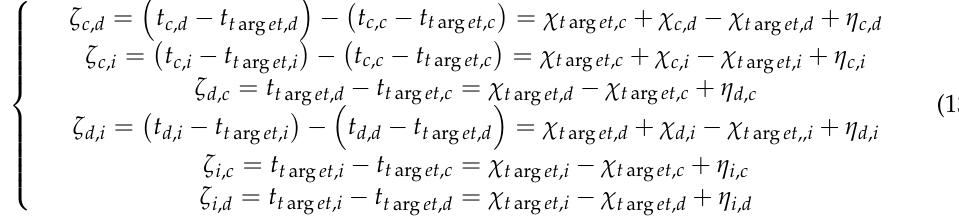
Figure 9. Location information structure